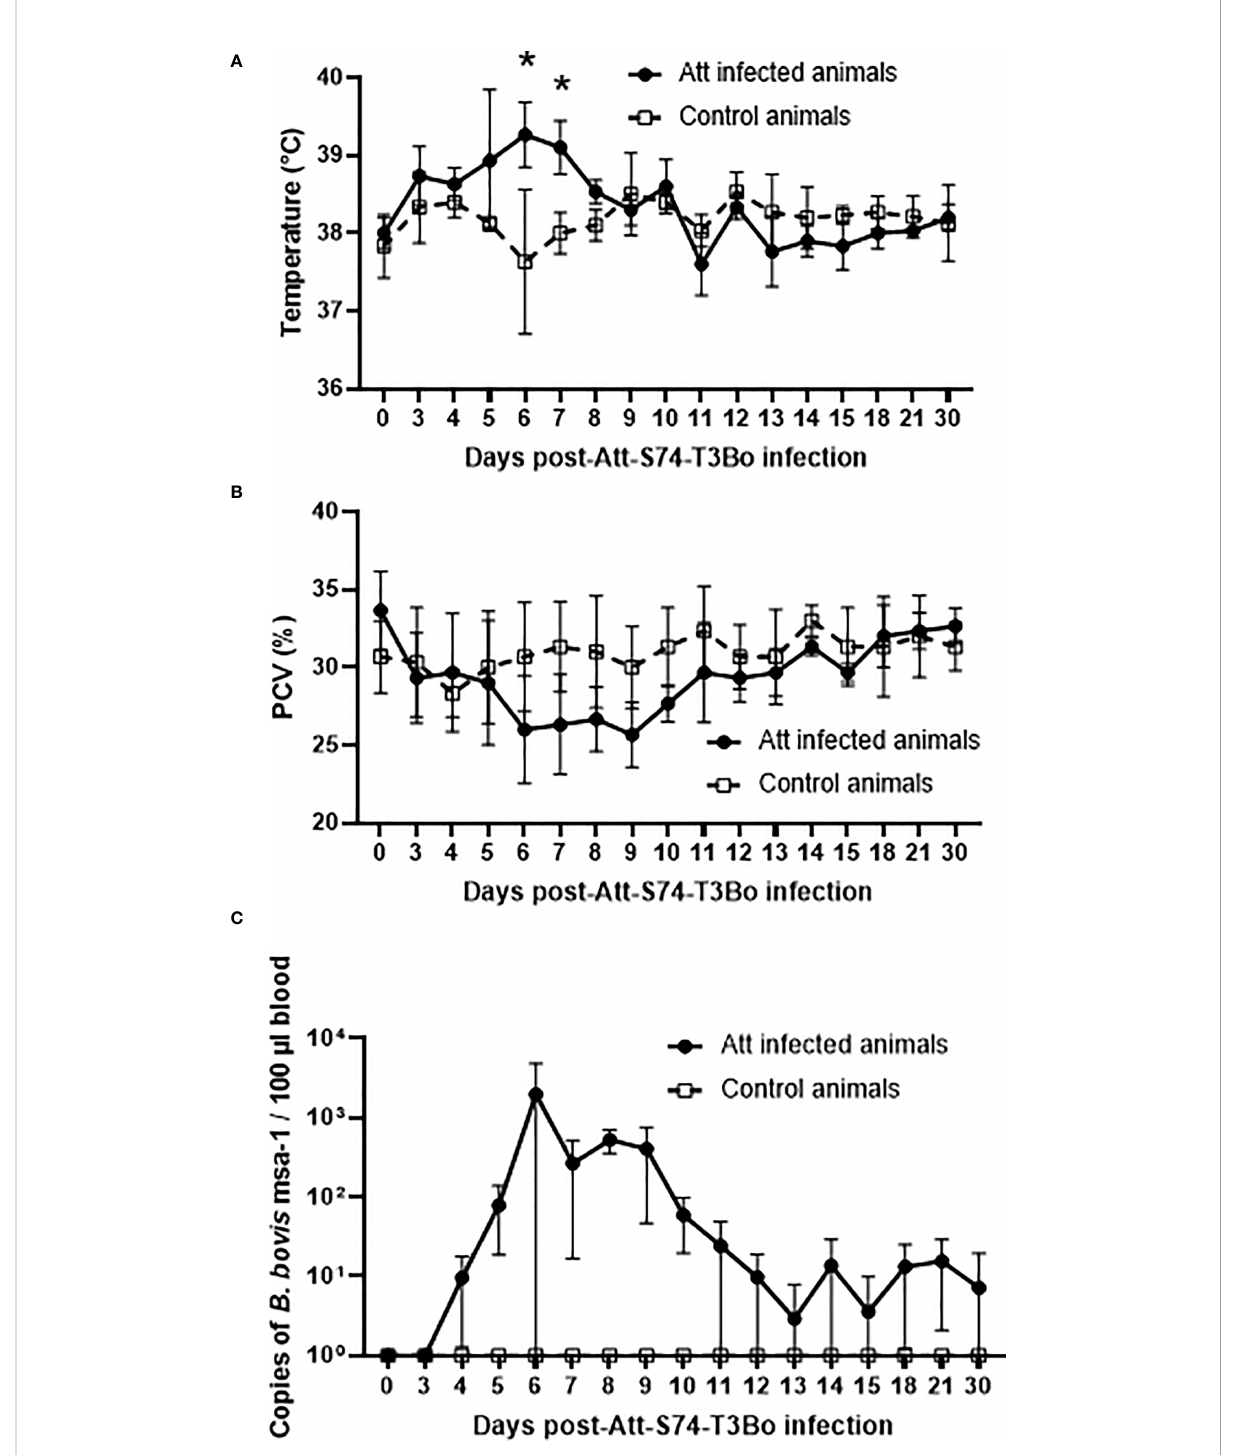
FIGURE 1 Temperature (A) , packed cell volume (PCV) (B) , and B. bovis load in peripheral blood accessed by real-time quantitative PCR (C) after infection with the in vitro culture attenuated B bovis strain Att-S74-T3Bo. Att infected animals (n=3). Control animals (n=3). *